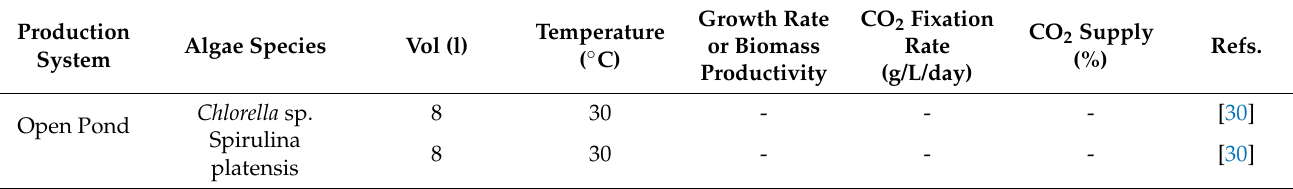
Table 1. Microalgae carbon sequestration by specie and production